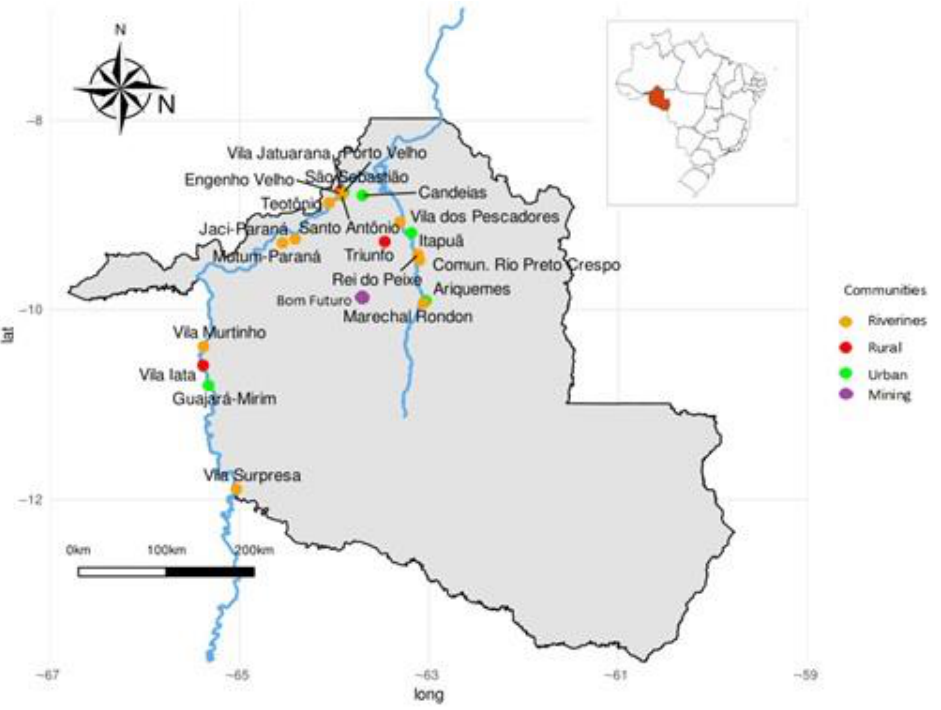
Figure 1. Study locations. Source: adapted from Marques et al. [26]. Participants’ data were obtained through questionnaires after written authorization.